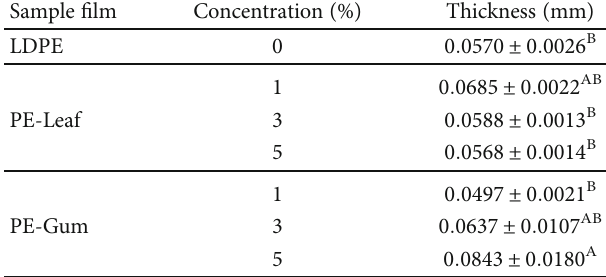
Table 1: Thickness ( mean ± SD ) of control and active fi